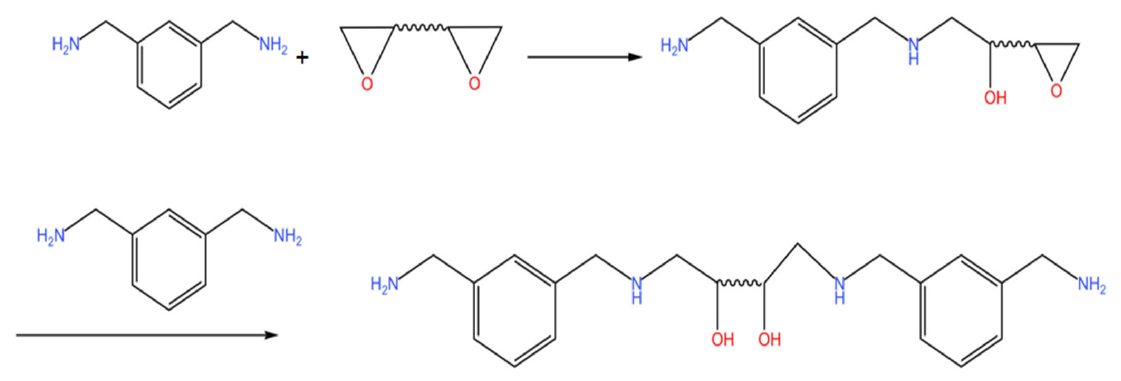
Figure 6. Synthesis route of a modified MXDA curing agent.